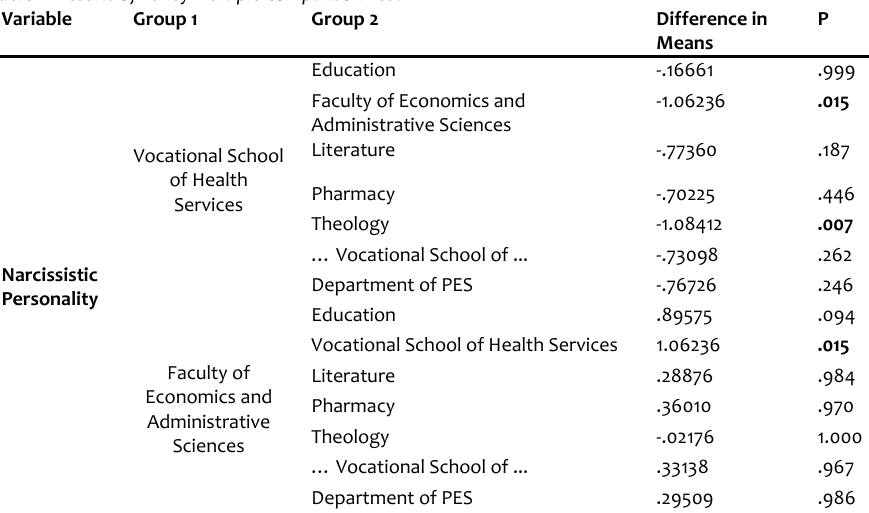
Table 2: Results of Tukey Multiple Comparison Test Variable Group 1